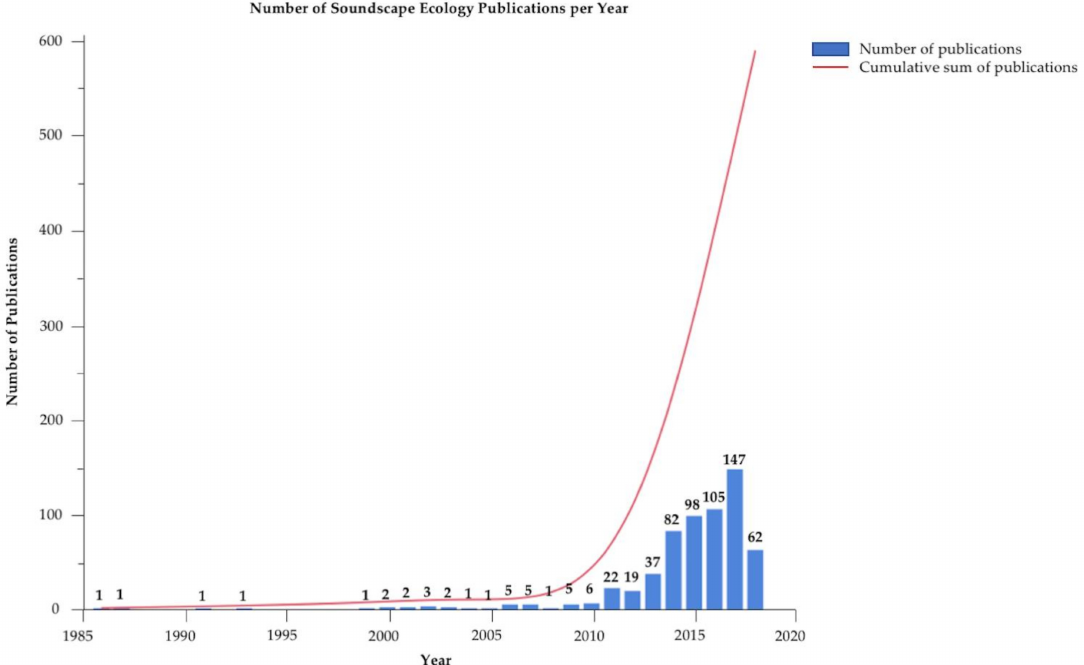
Figure 1. Number of “soundscape ecology” scientific papers published per year. Data derived by searching Google Scholar using only the keyword “soundscape ecology”, and does not reflect earlier works of describing underwater acoustics and marine animal sounds. The number above each bar is the number of publications for that